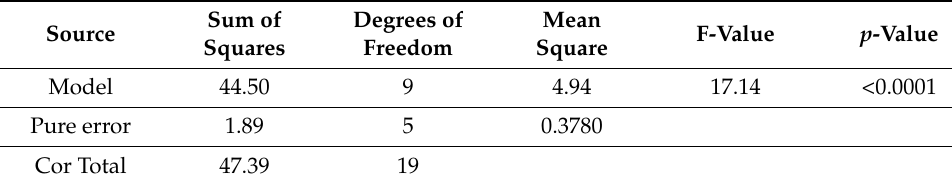
Table 3. Analysis of Variance for ricinoleic acid yield (g/kg).